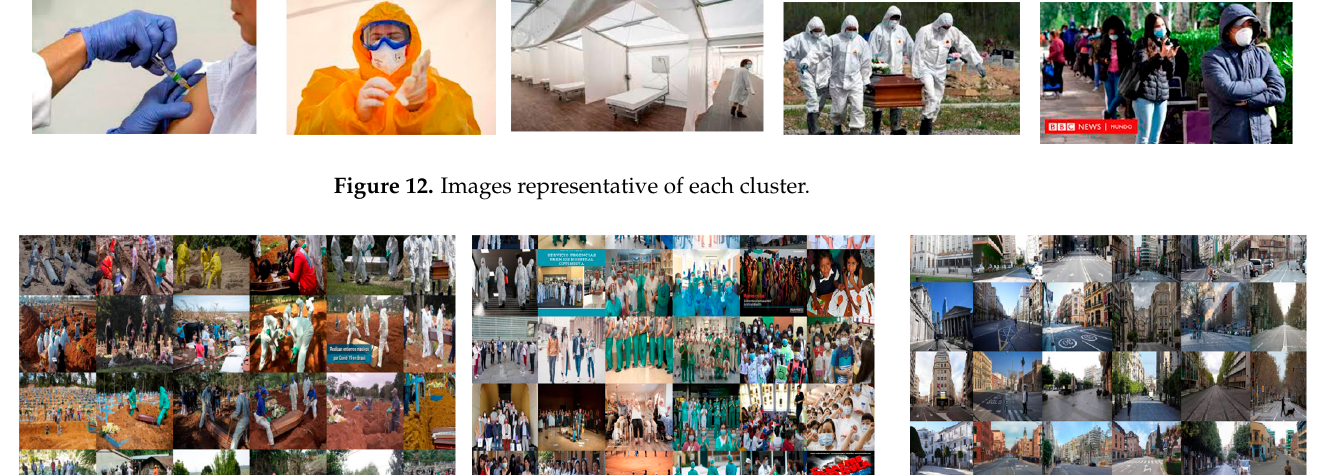
Figure 13. COVID-19 map detail. Cluster 8, Cluster 7, Cluster 1. © Pilar Rosado. In Figure 14 we see the COVID-19 map which reassigns the locations on a regular square grid, but without destroying the neighbor relations that resulted from the group- ing by similitude based on t-SNE.